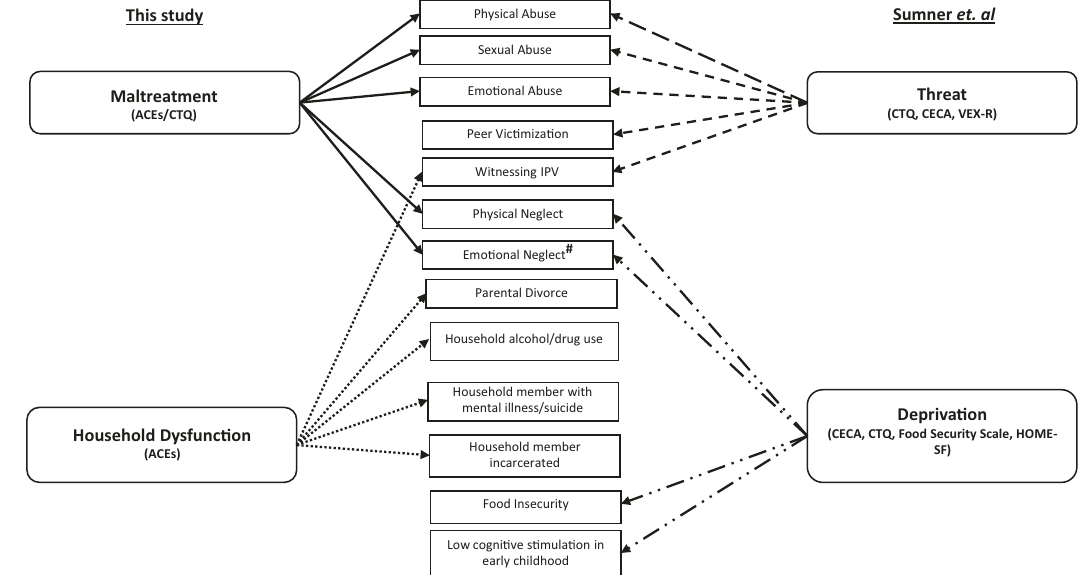
Fig. 1 Comparison of dimensions of childhood adversity. Here we show dimensions of adversity assessed in this study ( Maltreatment/ Household Dysfunction ) compared to the dimensions of Threat/Deprivation as assessed by Sumner et al. In parentheses, we show the scales utilized to create these composite scores. Individual items incorporated into each of these domains are shown in the center with arrows indicating to which dimensions they belong. Threat and Deprivation have been assessed using a multi-modal approach, while our study assessed exposures with the commonly utilized Childhood Trauma Questionnaire (CTQ) and Adverse Childhood Experiences (ACEs) questionnaire. We observed that Threat and Maltreatment are highly overlapping with the major differences being inclusion of neglect items and exclusion of witnessing IPV item into the dimension of Maltreatment . Peer victimization (PV) was not assessed in this study as we did not utilize the Violence Exposure Scale-Revised (VEX-R) which provides a measure of different types of peer victimizations experiences. Household Dysfunction and Deprivation were assessed utilizing different scales. # Emotional neglect was assessed in distinct ways between these studies. Speci fi cally, the ACEs/CTQ assesses subjective appraisals of emotional neglect. In prior studies which utilized the Threat/Deprivation framework, emotional neglect was speci fi cally assessed using the Childhood Experiences of Care and Abuse (CECA) which assesses neglectful behaviors (rather than an appraisal of the distant experience of neglect). Cognitive stimulation was assessed using Home Observation Measurement of the Environment